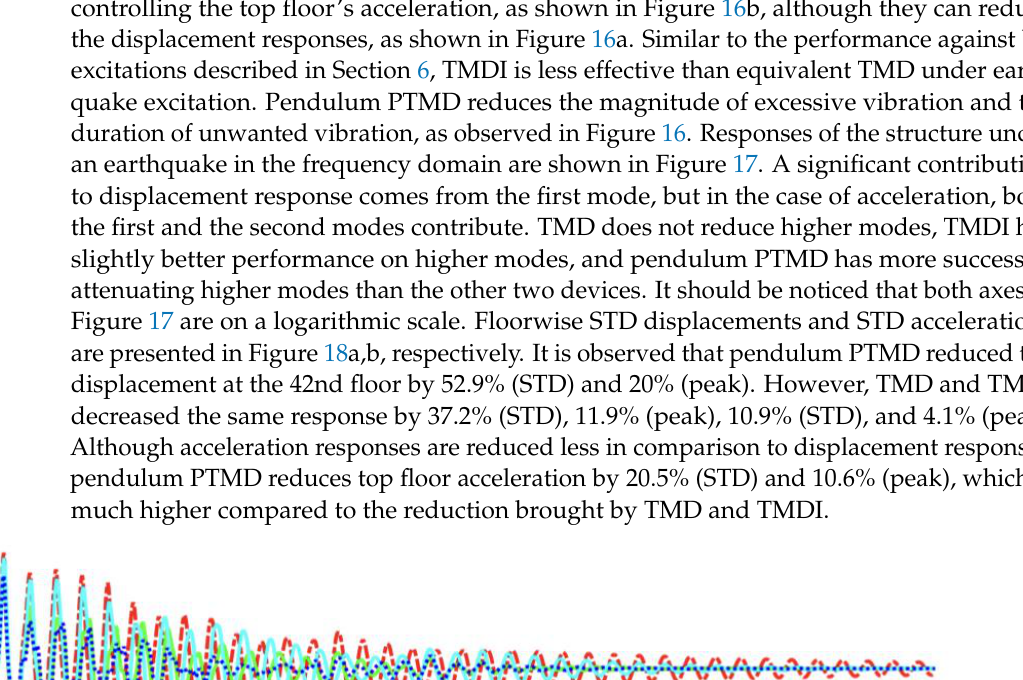
Figure 17. Response spectra of the 42nd story under El-Centro earthquake: ( a ) displacement and ( b ) acceleration. Interestingly, the reduction in peak acceleration by TMDI (6.5%) is slightly higher than the TMD (2.6%). This is because TMDI has enhanced control performance than TMD for higher modes, which can be observed from a closer look at Figure 18. This well-known fact supports the result that TMD cannot reduce peak acceleration, which is most often a significant cause of damage and destruction in high-rise buildings during seismic events. Nevertheless, pendulum PTMD performs better than TMD and TMDI among all modes, including the first mode. Figure 19 presents the floor-wise peak displacement and acceleration of the building. The floor displacement increases linearly over the height of the building, but the acceleration increases non-linearly. This observation shows that